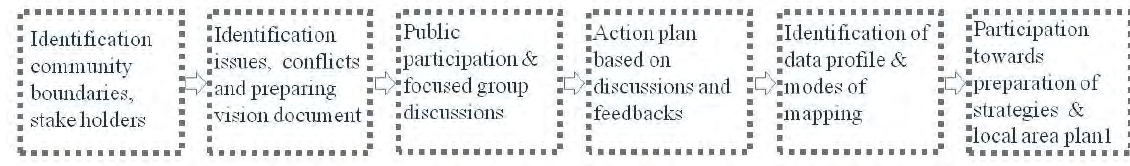
Figure 8. Local Area Planning Process